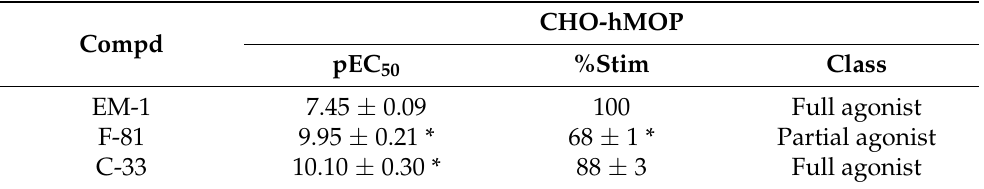
Table 1. G-protein activation ([ 35 S]GTP γ S binding) in response to different ligands.